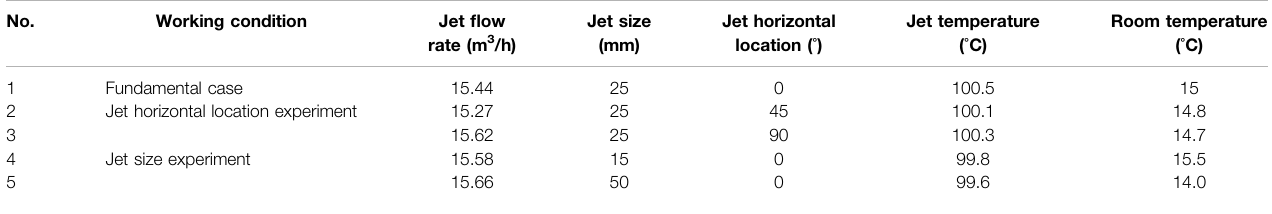
TABLE 2 | Experimental